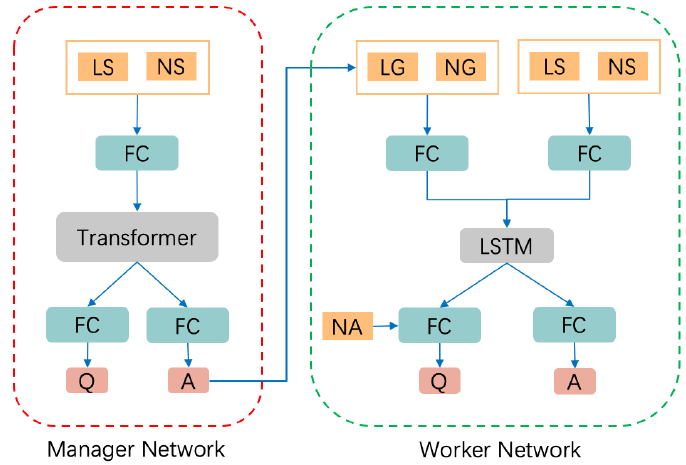
Figure 1. The architecture of our goal-based multi-agent hierarchical model. The red part is manager‘s network. The green part is worker‘s network. Workers make decisions based on goals passed on to them by